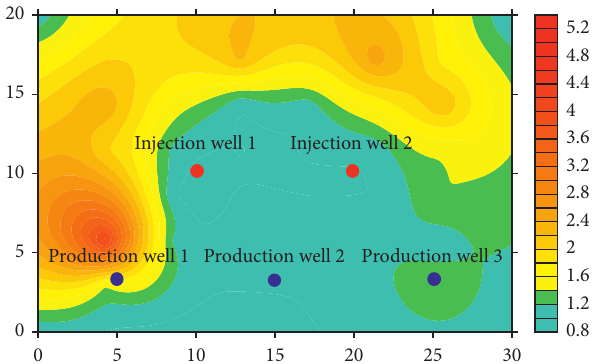
Figure 13: Field diagram of the dilution multiple after the chemical agent injection of 0.6PV with weak edge water.